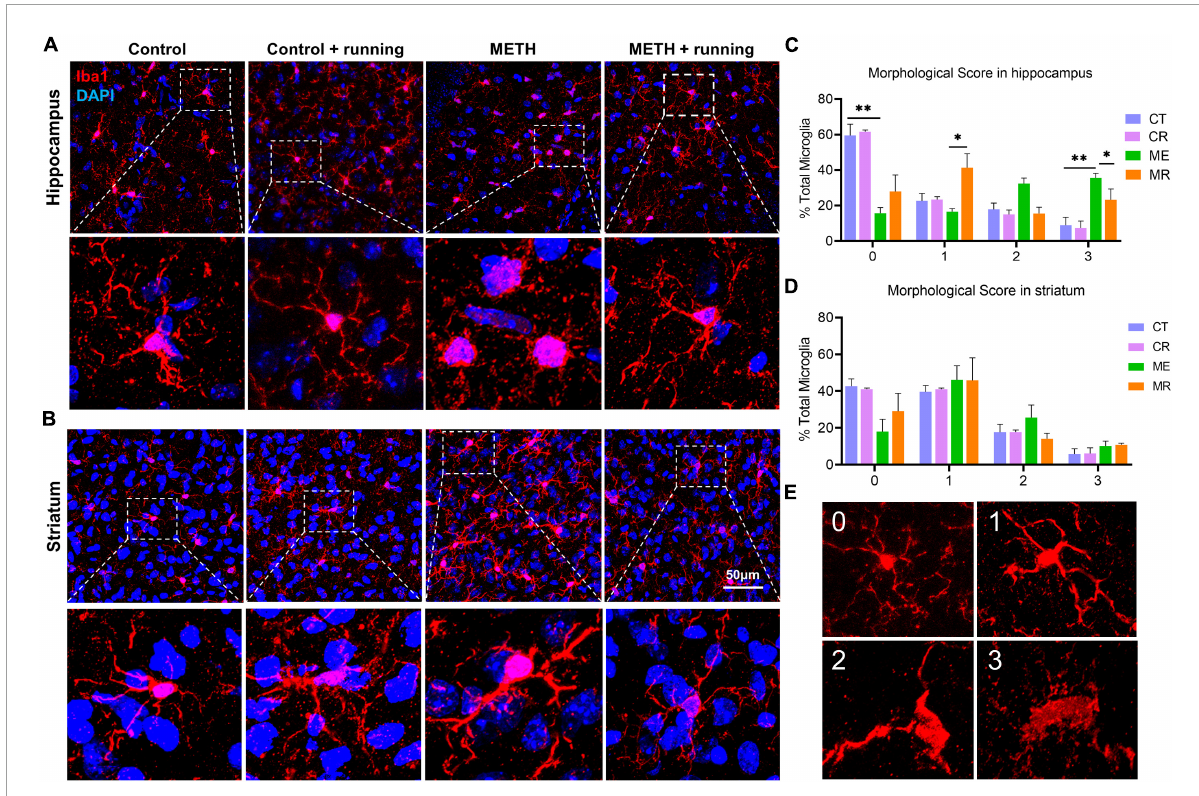
FIGURE5 The effects of treadmill exercise on the morphology of microglia in the hippocampus and striatum of mice with acute METH withdrawal. (A,B) Representative image of microglia morphology in the hippocampus (A) and striatum (B) . (C,D) These percentages are morphological scores for each type of microglia in the hippocampus (C) and striatum (D) . (E) Morphologically, the microglia with long and thin branching processes scored 0, 1 for microglia with thicker processes with branches; 2 for microglia with thick, retracted processes with few branches; and 3 for round microglia without processes. The data are expressed as the mean ± SEM. Significance is shown as ∗ p < 0.05, ∗∗ p < 0.01, ∗∗∗ p < 0.001, and ∗∗∗∗ p <